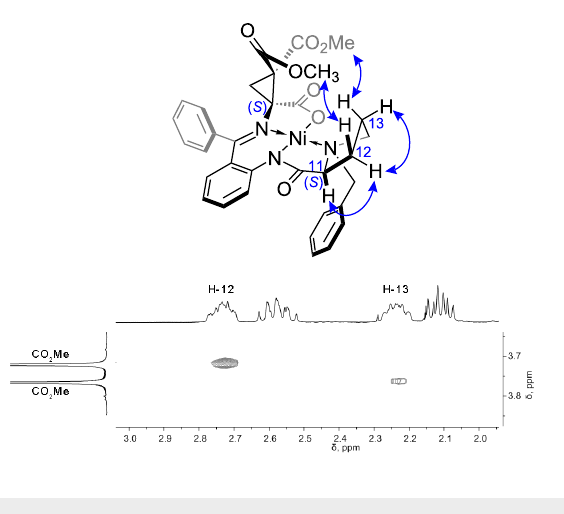
Figure 2: Key correlations in the NOESY spectrum of complex ( S )- 4 and the corresponding characteristic fragment of the spectrum (full spectrum is given in Supporting Information File